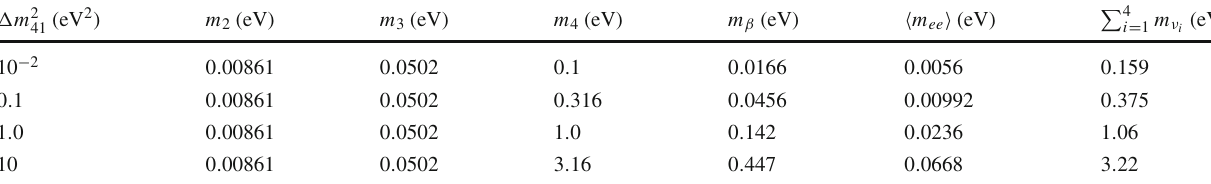
Fig. 7 m β (left panel) and (cid:8) m ee (cid:9) (right panel) versus s 34 and (cid:4) m 2 Table 3 Obtained parameters corresponding to some values of (cid:4) m 2